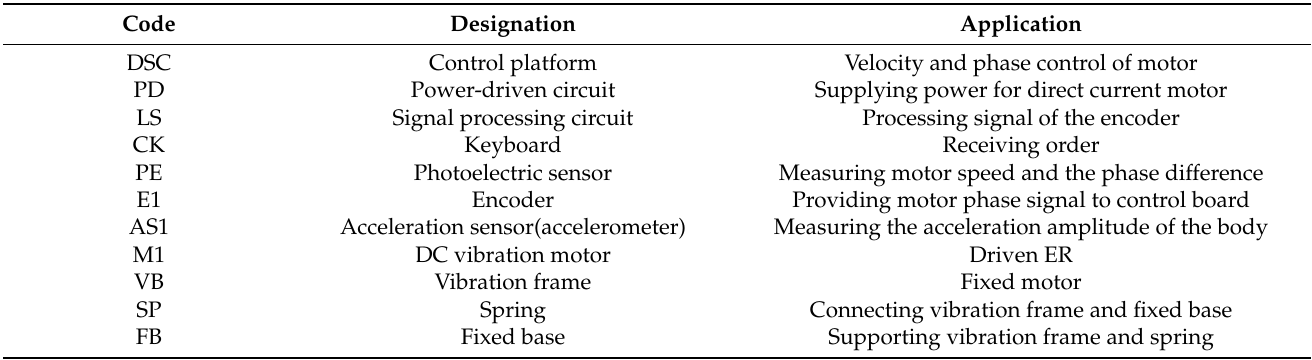
Figure 4. Control schematic diagram of the hardware circuit. Table 1. Code